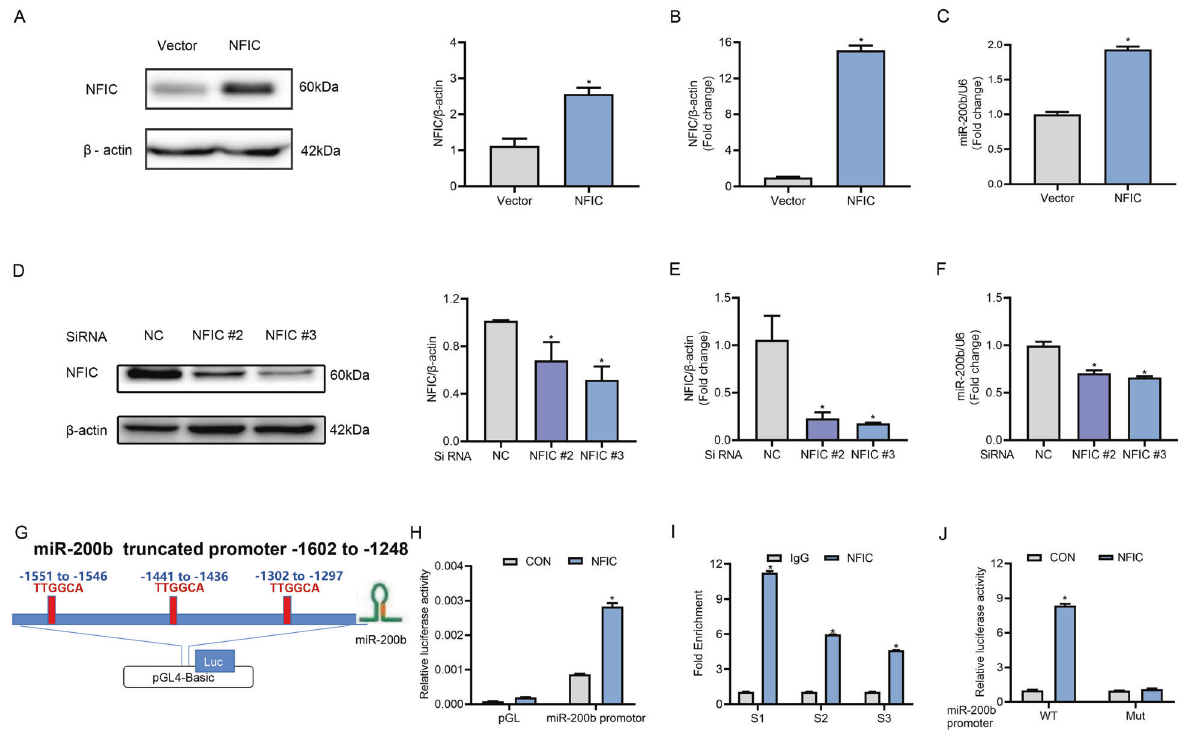
Fig. 2 NFIC positively regulates transcription of miR-200b. Changes in protein expression ( A ) and mRNA expression ( B ) of NFIC after transfection of the NFIC plasmid or the control vector in C17.2 neural stem cells. C RT-qPCR analysis of miR-200b levels in cells transfected with the NFIC plasmid or the control vector. Levels of NFIC protein ( D ) and mRNA ( E ) after transfecting the NFIC SiRNA or the control SiRNA into cells. F miR-200b levels after silencing NFIC with SiRNA in C17.2 cells. G A diagram showing the construct of the miR-200b promoter-luciferase reporter encompassing three binding motifs of TTGGCA. H The miR-200b promoter construct was cotransfected with the NFIC plasmid or the control vector into cells. Luciferase activity was assayed 48 h after transfection. I ChIP analysis of NFIC binding to the three conserved motifs in the promoter of miR-200b (S1, S2, and S3). J Luciferase activity was measured after cotransfection of the WT or Mut type of the miR-200b promoter with or without the NFIC plasmid in C17.2 cells. The results represent three repeated experiments. * P < 0.05 vs. control